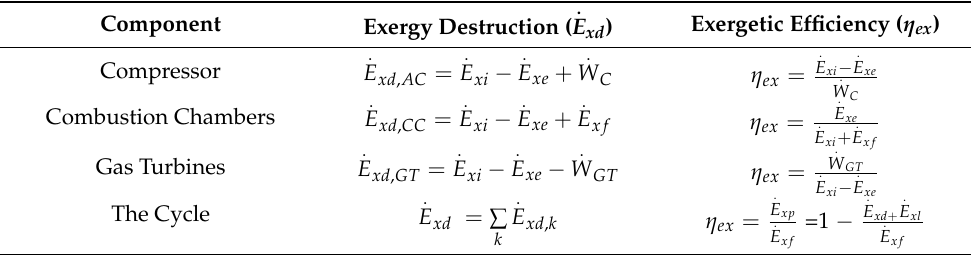
Table 6. Exergetic efficiencies and exergy destruction rates for different system elements under steady state